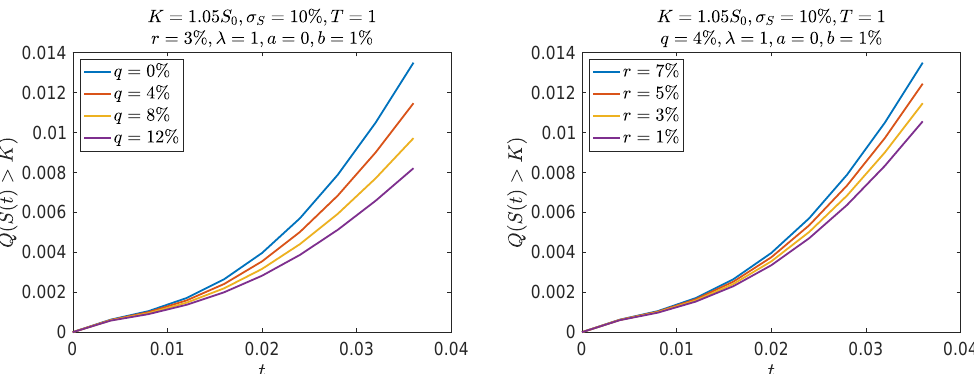
Figure 4. Probability that a call option on S in jump-diffusion framework is in the money at the first eight monitoring dates. Daily monitoring (250 dates for a T = 1 year